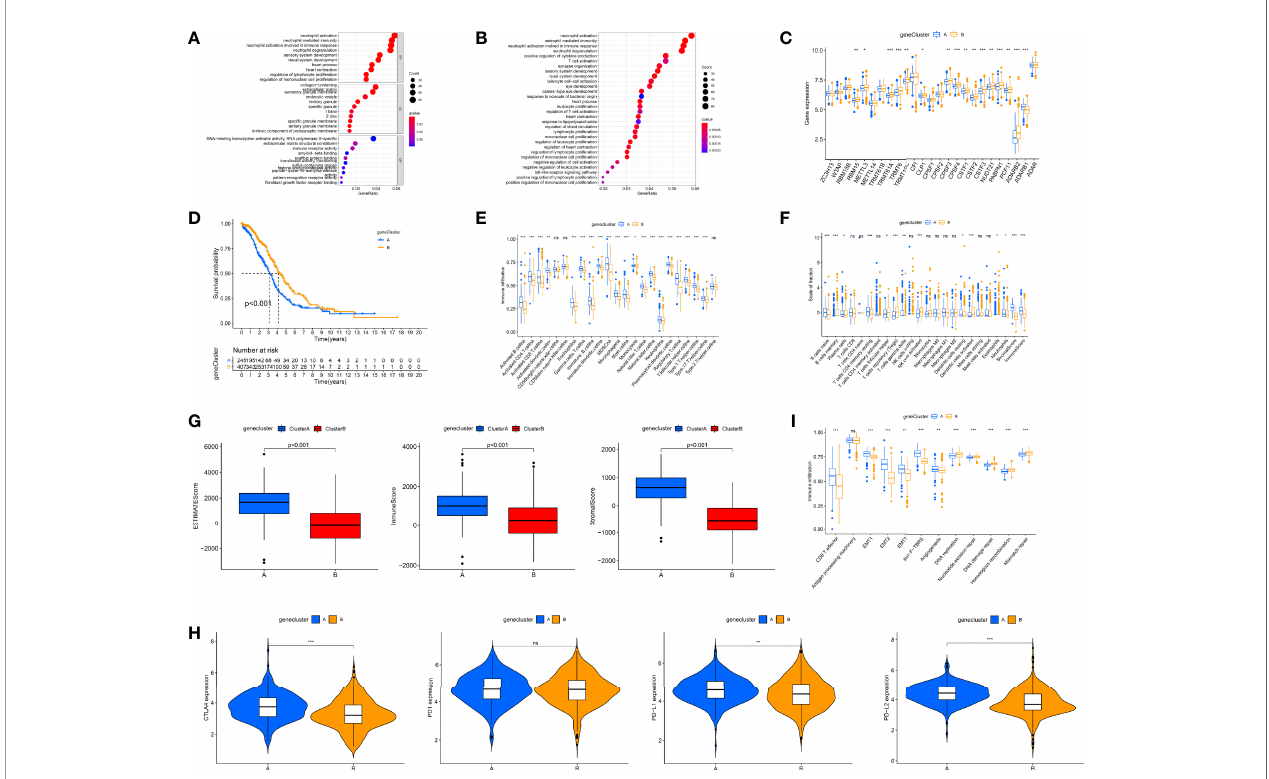
FIGURE 4 | Identi fi cation of gene clusters based on differentially expressed genes (DEGs) and tumor immune microenvironment (TME) cell in fi ltration characteristics and transcriptome traits in distinct gene clusters. (A) Gene Ontology (GO) enrichment analyses of DEGs among two gene clusters. (B) Kyoto Encyclopedia of Genes and Genomes (KEGG) enrichment analyses of DEGs among two gene clusters. (C) Differences in the expression of 26 RNA modi fi cation “ writers ” among the two gene clusters. (D) Kaplan – Meier curves for the two gene clusters of ovarian cancer (OC) patients. (E) 23 TME cells ’ in fi ltration abundance of two gene clusters. (F) The proportion of each immune cell in two gene clusters. (G) Correlations between two gene clusters and TME score. (H) Expression levels of CTLA4, PD-1, PD- L1, and PD-L2 in two gene clusters. (I) Differences in interstitial activation pathways of two gene clusters. Adjusted p-values were shown as ns, not signi fi cant; * p < 0.05; ** p < 0.01; *** p <